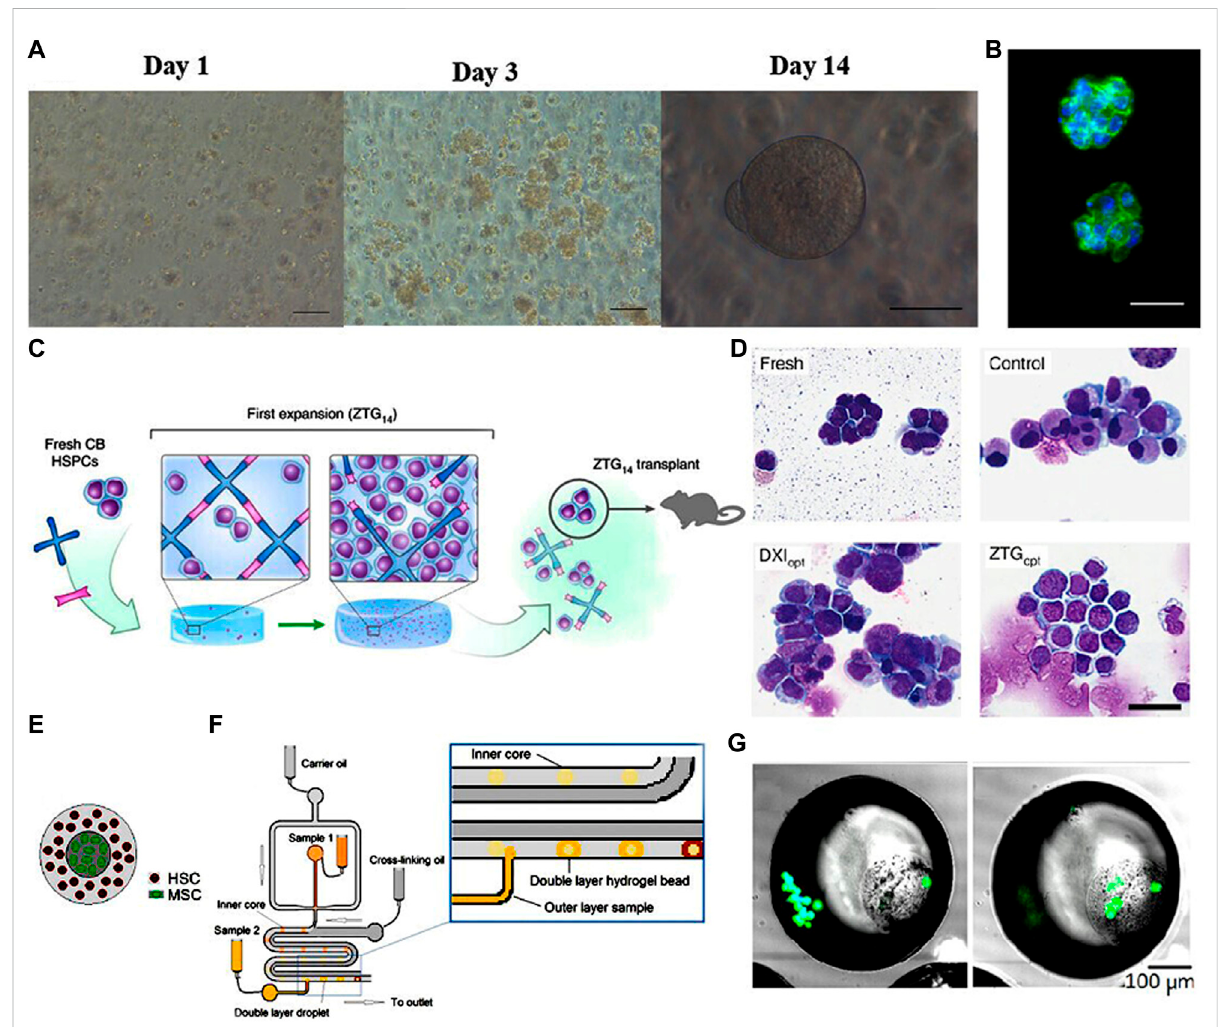
FIGURE 3 (A) Phase contrast images of HSCs encapsulated within bioactive PEG hydrogels at days 1, 3, and 14 showing the proliferation and round shape retention of HSCs. Scale bar: 100 mm (day 1, day 3), 50 mm (day 14). (B) DAPI (blue) and phalloidin (green) staining of HSCs after 14 days expansion showing the cell morphology retention and gel structure integrity. Scale bar: 25 mm. (Cuchiara et al., 2016) Figure 3A, B: Copyright © 2015. Reproduced with permission from John Wiley and Sons. (C) Schematic illustration of the zwitterionic hydrogels with superhydrophilicity and volumetric swelling. (D) Photomicrograph of Wright-Giemsa-stained HSCs showing the signi fi cant expansion of the primitive HSC population in zwitterionic hydrogels. Scale bar: 30 μ m. (Bai et al., 2019) Figure 3C, D: Copyright © 2019. Reproduced with permission from Springer Nature. (E) SchematicrepresentationofthedoublelayeredhydrogelbeadwithHSCsontheoutercoreandMSCsontheinnercore. (F) Schematicillustrationof the double layered structure fabrication process using droplet-based micro fl uidic. (G) Fluorescent staining of viable MSCs and HSCs show that both types of cells are successfully encapsulated in the double layered structure. (Carreras et al., 2018) Figure 3E-G: Copyright © 2018. Reproduced with permission from